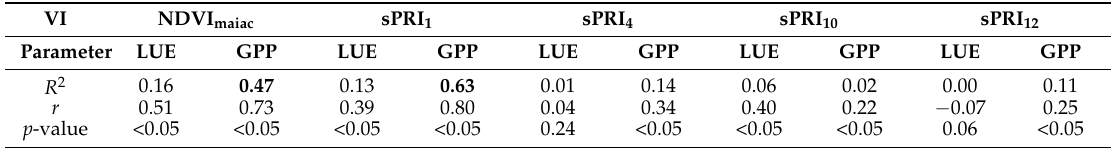
Figure 2. Times series of flux tower measured scaled Net Ecosystem Exchange (NEE) ( a ) and MODIS vegetation indices smoothed according to four different methods: Application of Gaussian functions, double sigmoidal functions, fast Fourier transform (FFT) and a Savitzky–Golay filter. The MODIS time series are: MAIAC-processed scaled PRI ( b ); and NDVI data ( c ); and MODIS standard NDVI product MOD13Q1 ( d ) and ( e ) scaled PAR. Table 2. Statistics of correlation analysis between GPP/LUE and NDVI and four different PRIs. The highest R 2 values observed are highlighted in bold and insignificant relationships are marked in grey. R 2 : Coefficient of determination, r : correlation coefficient (rho from Spearman Rank’s test significant at p < 0.05). Sample size = 766.